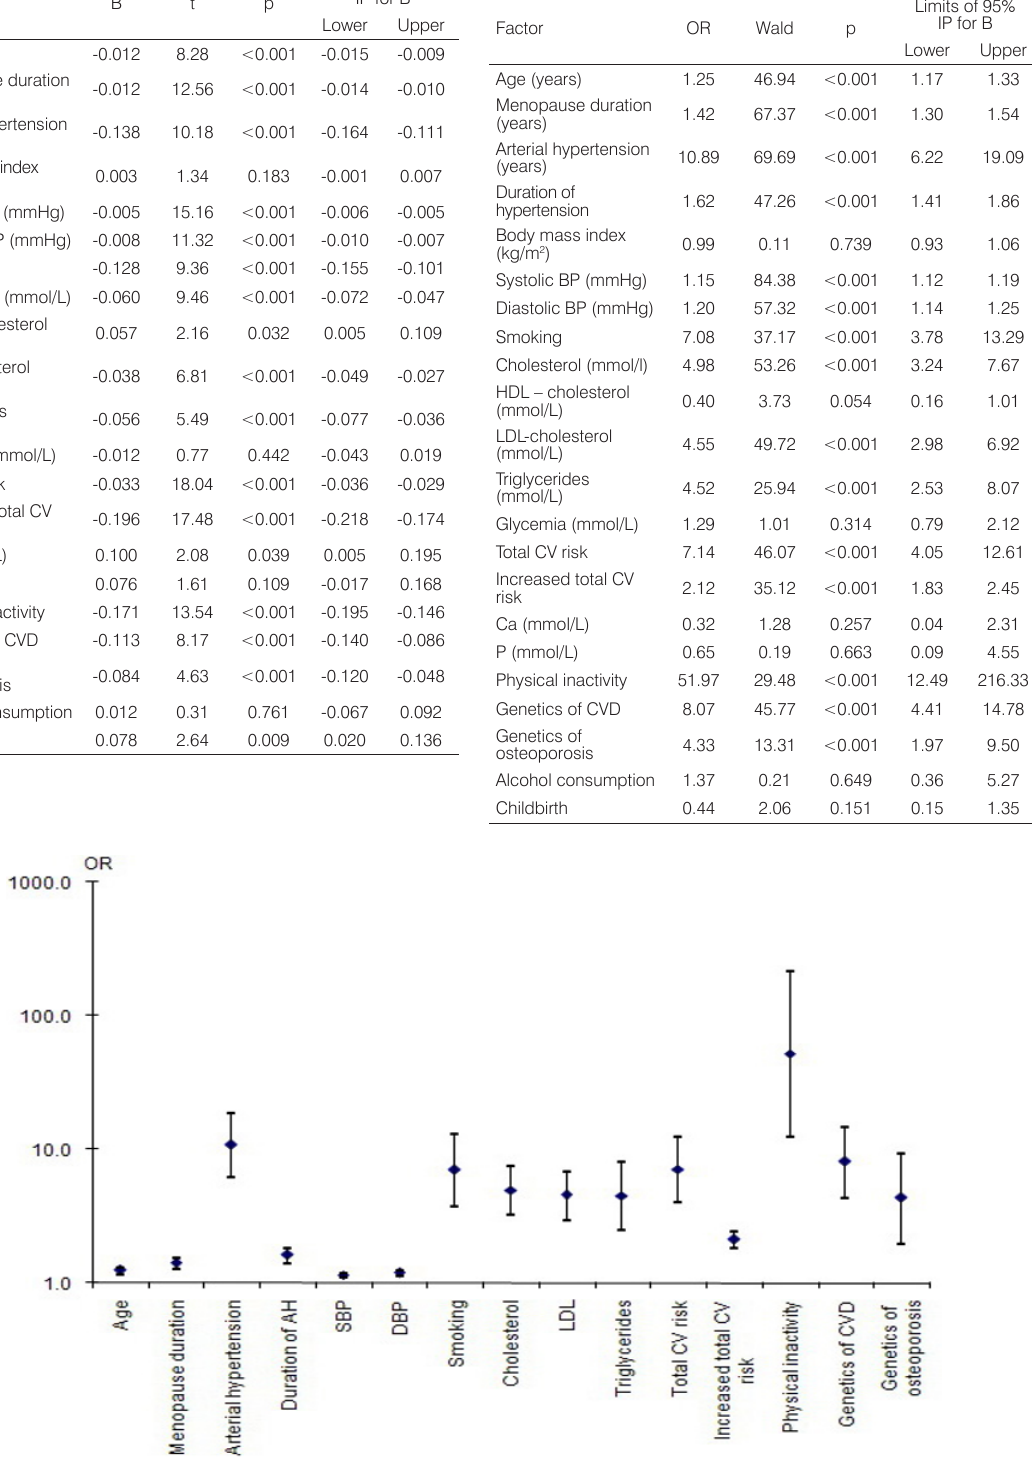
Figure 2. Values of OR and their 95% CI for the estimation of significant factors' influence on bone density – results of univariate logistic regression